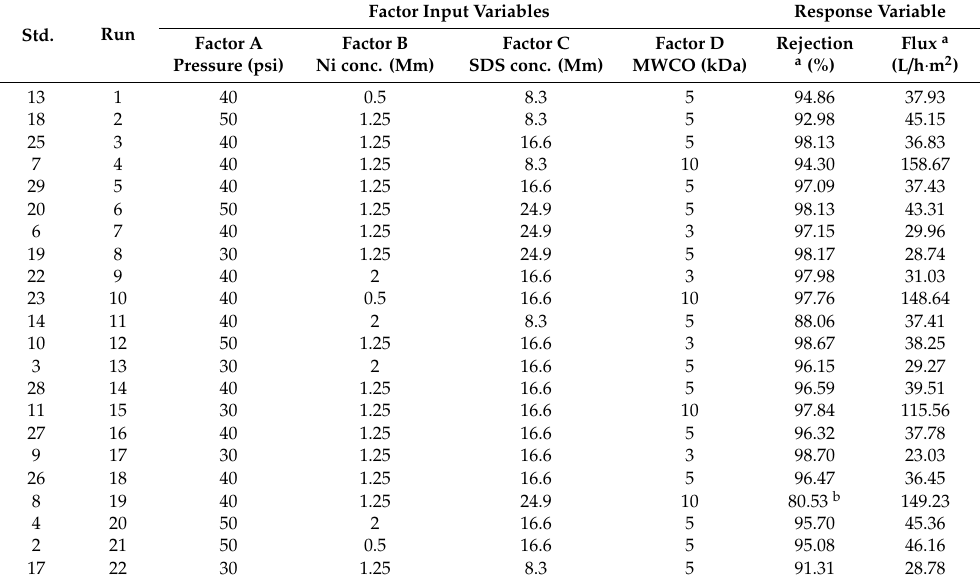
Table 4. Design layout and experimental results of BBD